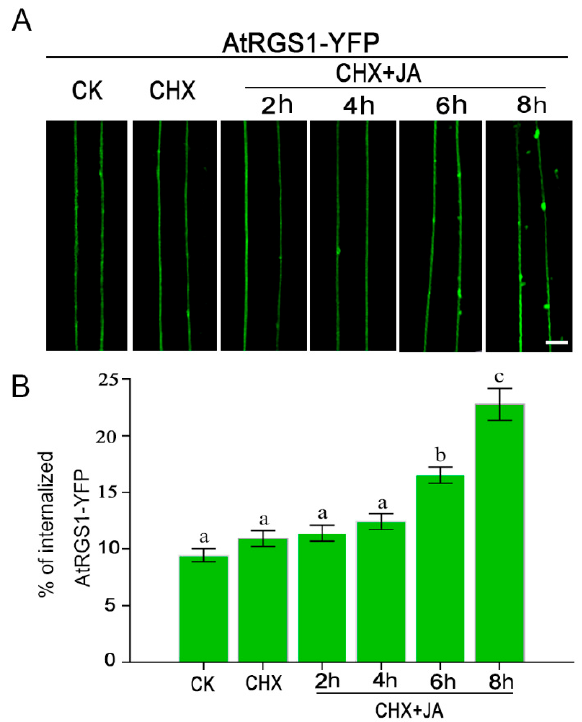
Figure 2. JA induces the endocytosis of AtRGS1. ( A ) Confocal images of AtRGS1-YFP localization without treatment (CK), with CHX treatment and with MeJA plus CHX pretreatment for indicated times in an Arabidopsis hypocotyl epidermal cell. Bar = 5 µ m. ( B ) Quantification of the internalized AtRGS1-YFP without treatment (CK), with CHX treatment, and with MeJA plus CHX pretreatment for indicated times. Error bars represent SD ( n = 5–8). Significant di ff erences are denoted by letters (Duncan multiple-comparisons test; values within the column followed by the same letter show no significant di ff erence ( p > 0.05), whereas those with the di ff erent letter indicate significant di ff erence ( p <